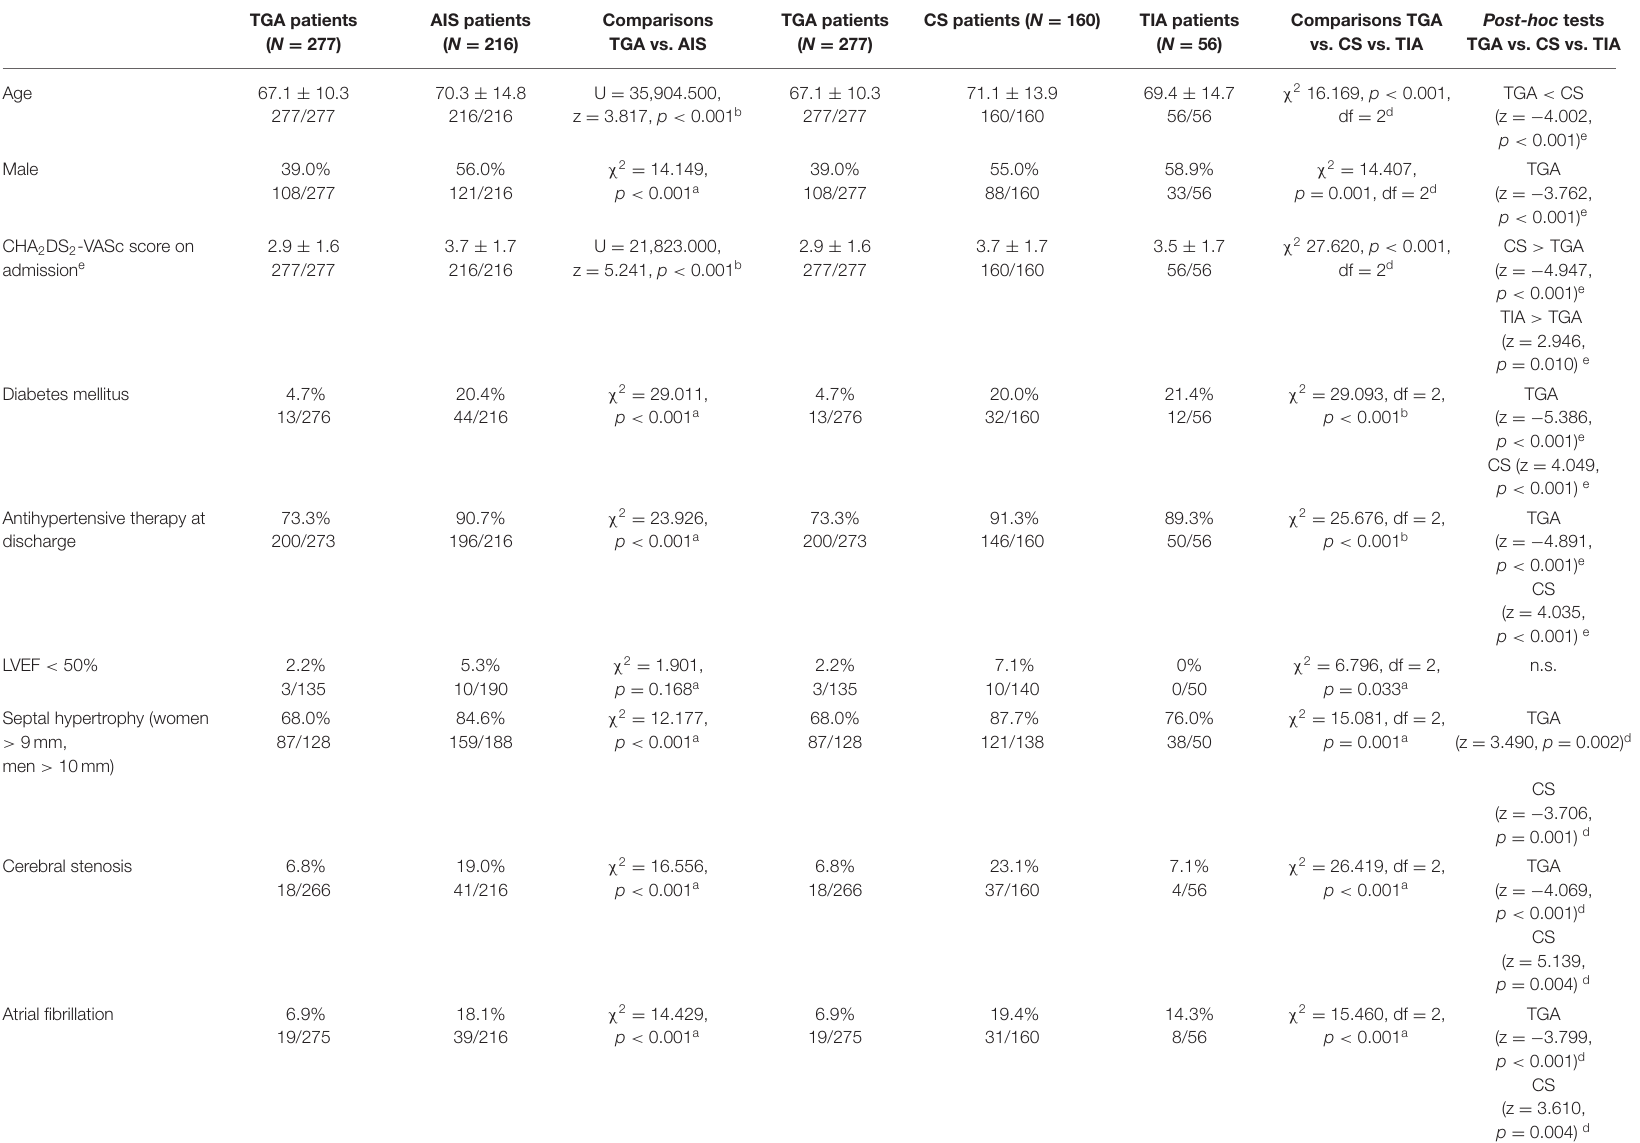
TABLE 2 | Comparison of TGA patient characteristics with AIS patients (columns 2–4) and comparison of TGA patient characteristics with CS-patients and TIA-patients (columns